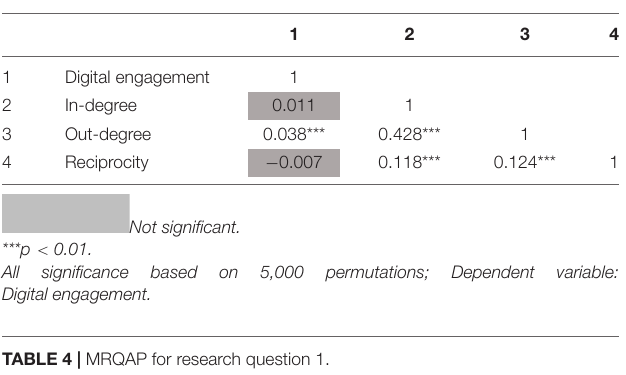
TABLE 3 | QAP correlations for research question 1.